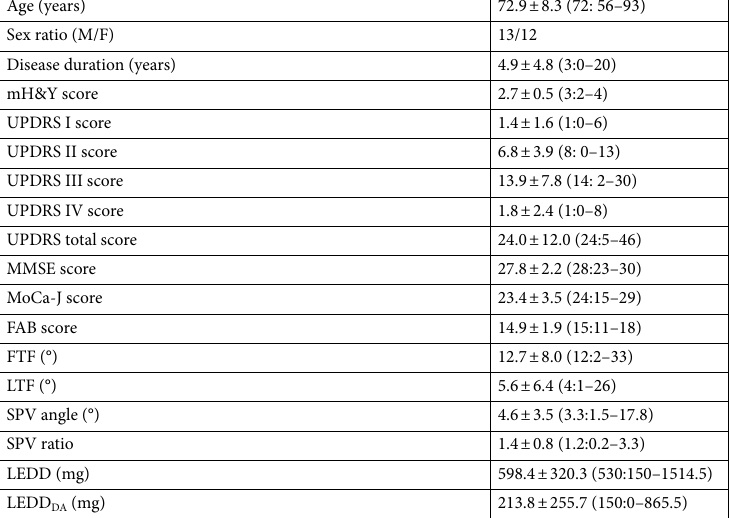
Table 1. Characteristics of the study patients at the time of initial evaluation (n = 25). Mean ± SD (median: range) values are shown, unless otherwise indicated. mH&Y modified Hoehn and Yahr stage, UPDRS